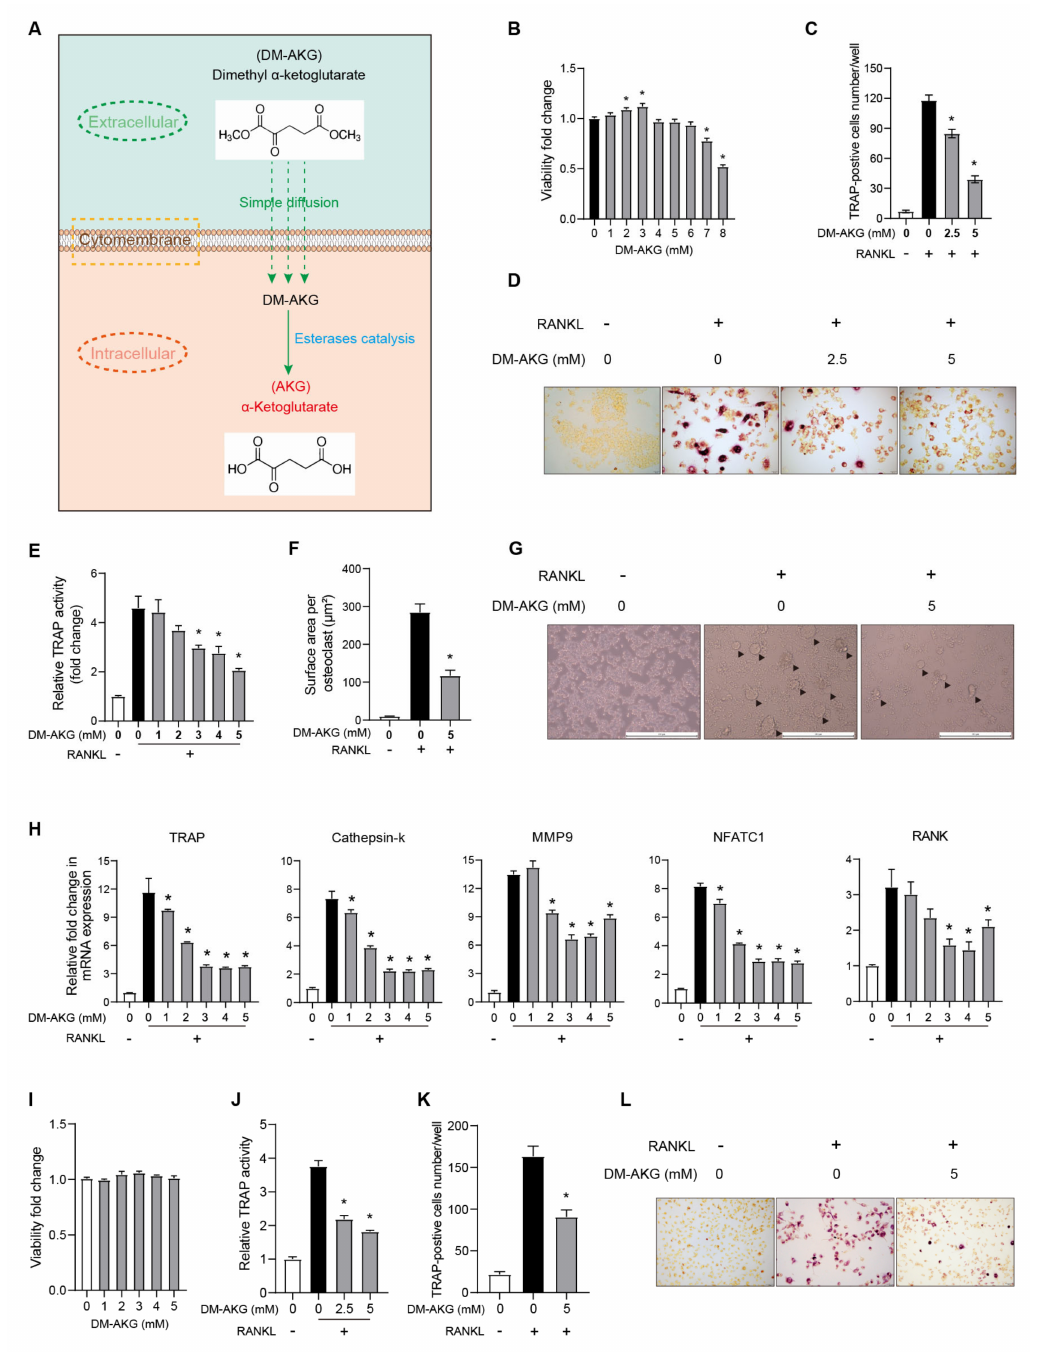
Figure 1. DM-AKG inhibits RANKL-induced osteoclast differentiation from RAW264.7 cells and BMMs. ( A ) Schematic illustration of DM-AKG entering cells and further being cleaved to AKG. ( B ) Effects of DM-AKG on the viability of RAW264.7 cells ( n = 7). ( C ) Quantification of osteoclasts by TRAP staining, ( D ) representative photomicrographs of TRAP-positive cells, ( E ) TRAP activity, and ( H ) mRNA levels of osteoblast marker genes in RAW264.7 cells treated with DM-AKG and RANKL for 3 d ( n = 3). ( F ) Surface area of multinucleated osteoblast ( n = 3) and ( G ) representative images of multinucleated osteoclast under various conditions for 5 days. The osteoclasts were indicated by black triangles. ( I ) Effects of DM-AKG on the viability of BMMs ( n = 4). ( J ) TRAP activity ( n = 3), ( K ) TRAP-positive cell number ( n = 3), and ( L ) representative images of osteoblast differentiated from BMMs for 4 d. All data were presented as means ± SEM. *, p <